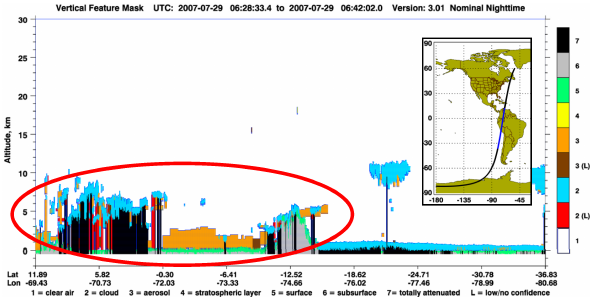
Fig. 8. CALIOP feature mask for case study I from 29 July, Fig. 8: CALIOP feature mask for Case Study I from 29 July, 06:30UTC, highlighting pollution and cloud features in orange and 06:30 UTC, highlighting pollution and cloud features in or- cyan, respectively. The region of pollution trajectory ends is circled ange and cyan, respectively. The region of pollution trajec- tory ends is circled red.